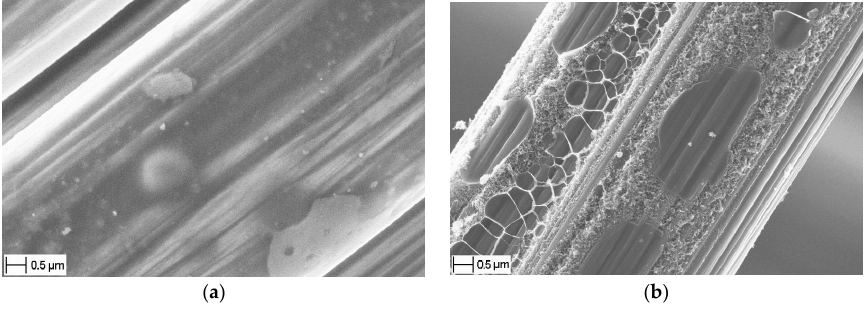
Figure 1. Fibers with the original Torayca sizing ( a ) and fibers in the “desized” fabric ( b ).